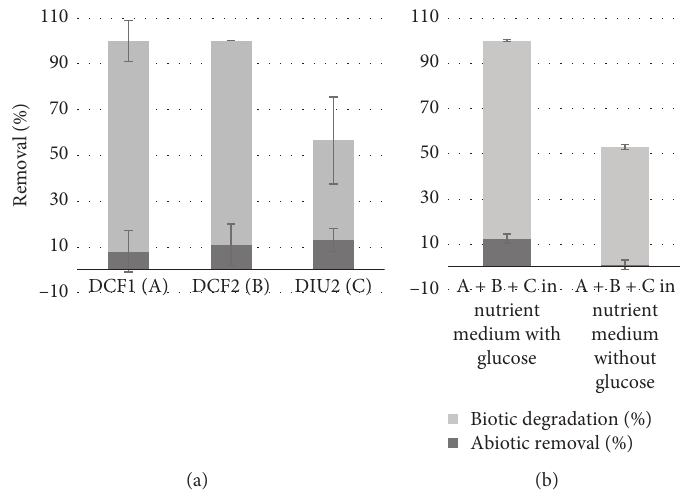
Figure 1: Removal of diclofenac using DCF1, DCF2, and DIU2 (A, B, and C, respectively), and conditions at 20 ° C after 3 days of degradation. The experiments were performed in triplicate in nutrient medium with or without glucose. Values are means ± standard error of the mean (SEM) ( n �